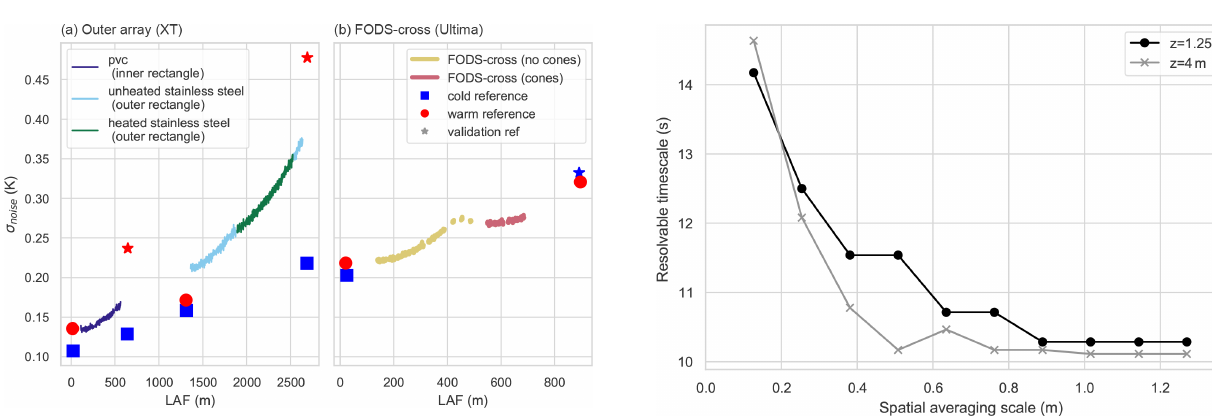
Figure 7. The scale at which the spectral coherence (Eq. 1) be- tween the sonic anemometer and unheated tower temperatures falls below 0.01 for increasing spatial averaging centered on the LAF bin √ nearest the indicated sonic 10 to